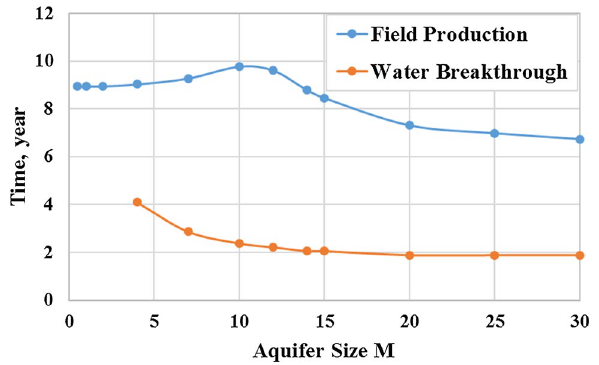
Fig. 31 Total water production for different horizontal permeabilities at various aquifer